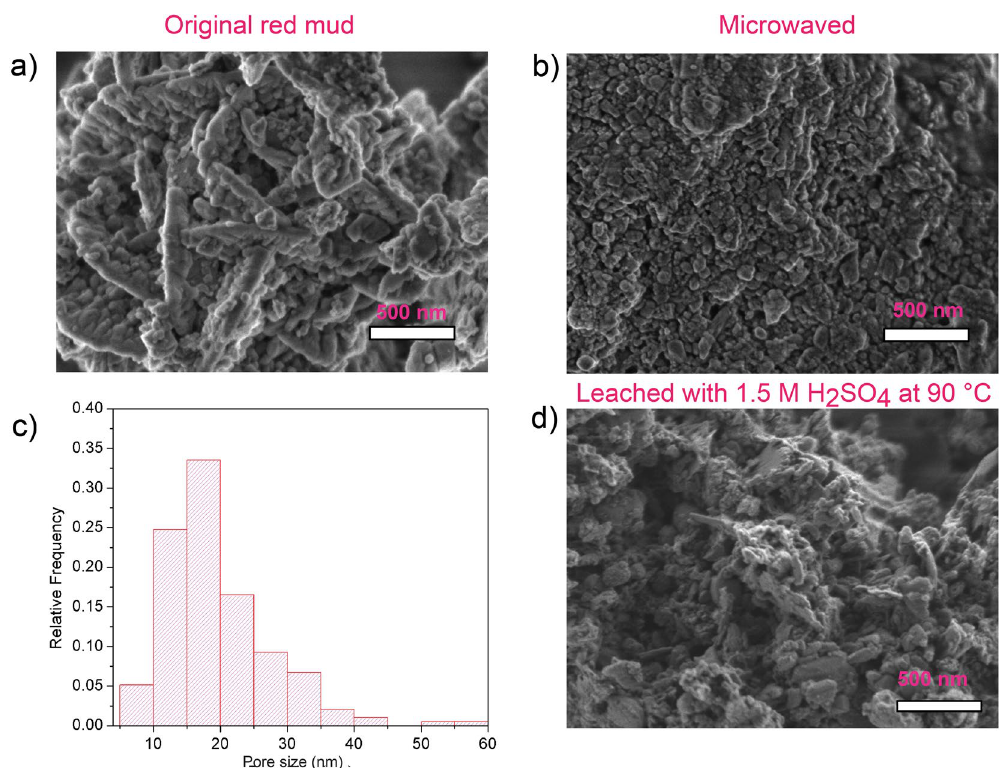
Figure 5. SEM images of ( a ) original bauxite residue; ( b ) microwave treated bauxite residue, nano-pores were developed; ( c ) histogram of pore size in microwave treated sample, and ( d ) bauxite residue leached in 1.5 M H 2 SO 4 at 90 °C for 30